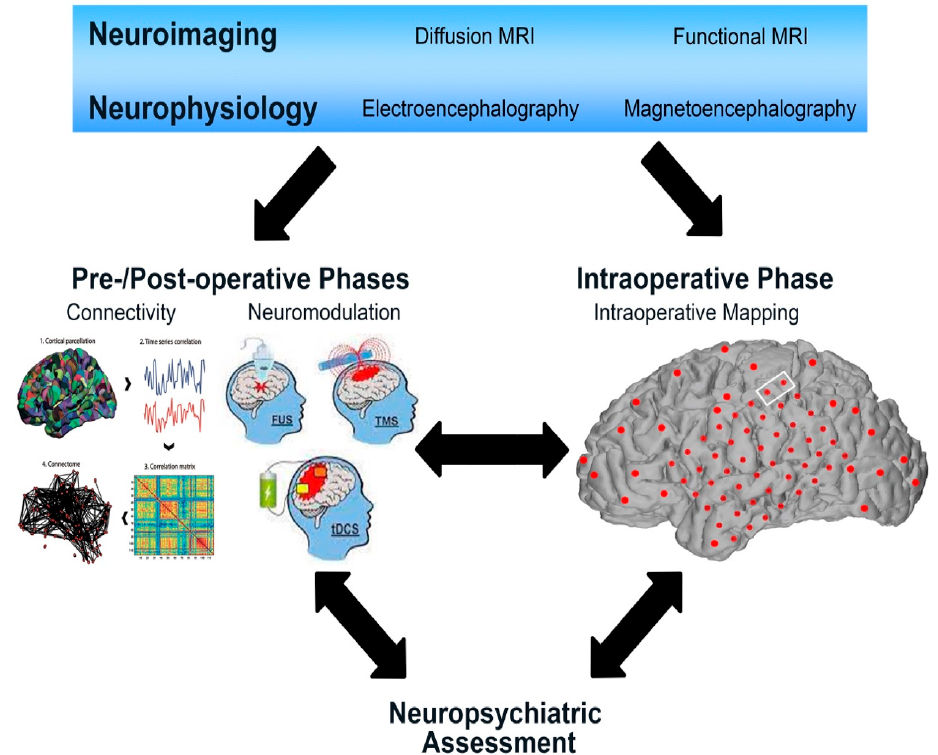
Figure 3. Visual representation of the integration of connectivity into the neurosurgical care management of glioma. Pre- operative investigations, including neuroimaging and neurophysiology, can be used to derive pre- and post-operative connectivity analyses and can also serve to inform neuromodulatory strategies for pre-habilitation or post-operative neu- rorehabilitation. Intraoperative mapping can be used as an adjunct mapping tool, and the functions assessed can be de- rived from connectivity analyses. Neuropsychiatric assessment can occur simultaneously to validate and assess cognitive and behavioral functions and correlate these with